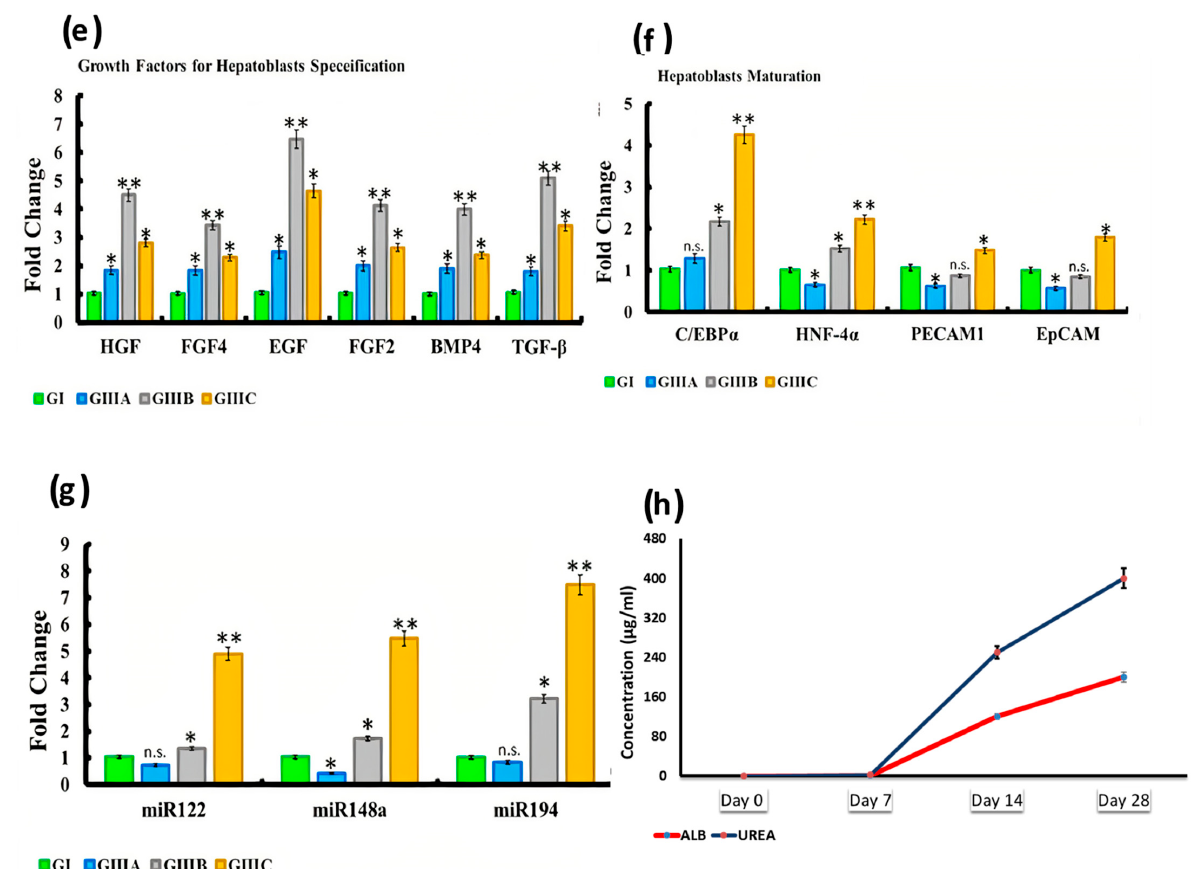
Figure 3. Histogram showed ( a ): Quantitative analysis for relative expression of OCT4, SOX2 & Nanog before the perfusion technique and after iPSCs differentiation within the 3D bio-scaffolds; ( b – g ): Quantitative analysis for relative expression of FOXA1, FOXA2, FOX17, HHEX, FGF2, BMP4, HGF, FGF4, EGF, TGF- β , Prox1, CK19, C/EBP α , HNF-4 α , AFP, ALB, HLX, PECAM, EpCAM, miR122, miR148a, and miR194 genes after iPS cells implantation. ( h ): Detection of albumin and urea concentration in the perfusion medium by ELISA from different experimental groups. The significant differences against the control group indicated by a * for p < 0.05 and a ** for p < 0.01. Data are shown as mean ± S.E.M, n = 7. GI (native liver), GIIIA (4 days recellularization), GIIIB (14 days recellularization) and GIIIC (24 days recellularization).